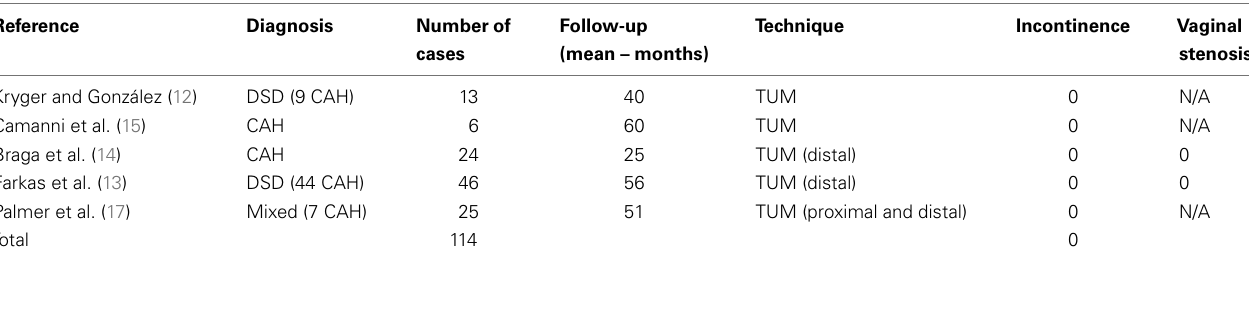
Table 1 | Summary of published results regarding urinary continence afterTUM